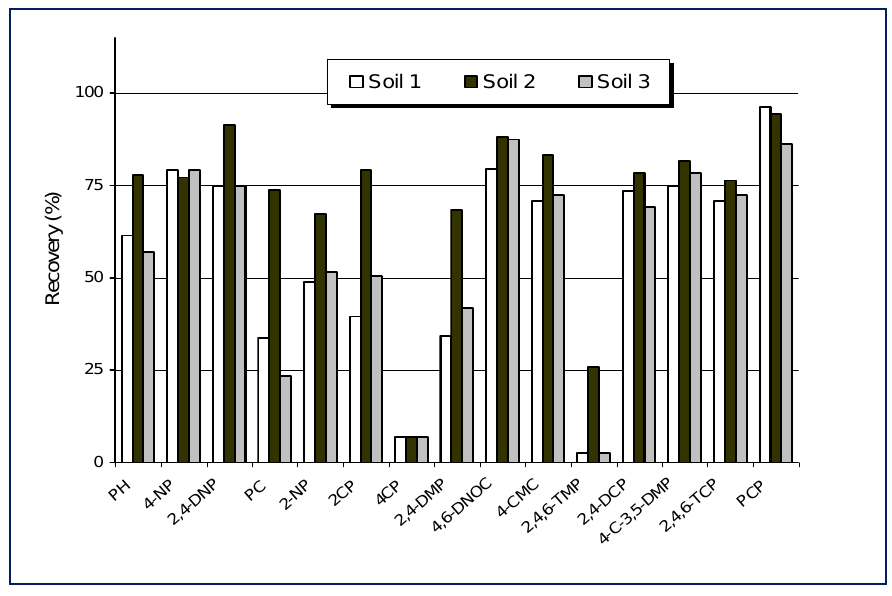
Figure 4 . Recoveries obtained for phenolic compounds in three different soil samples for eight weeks after conditioning after the MAME procedure (from Ref.